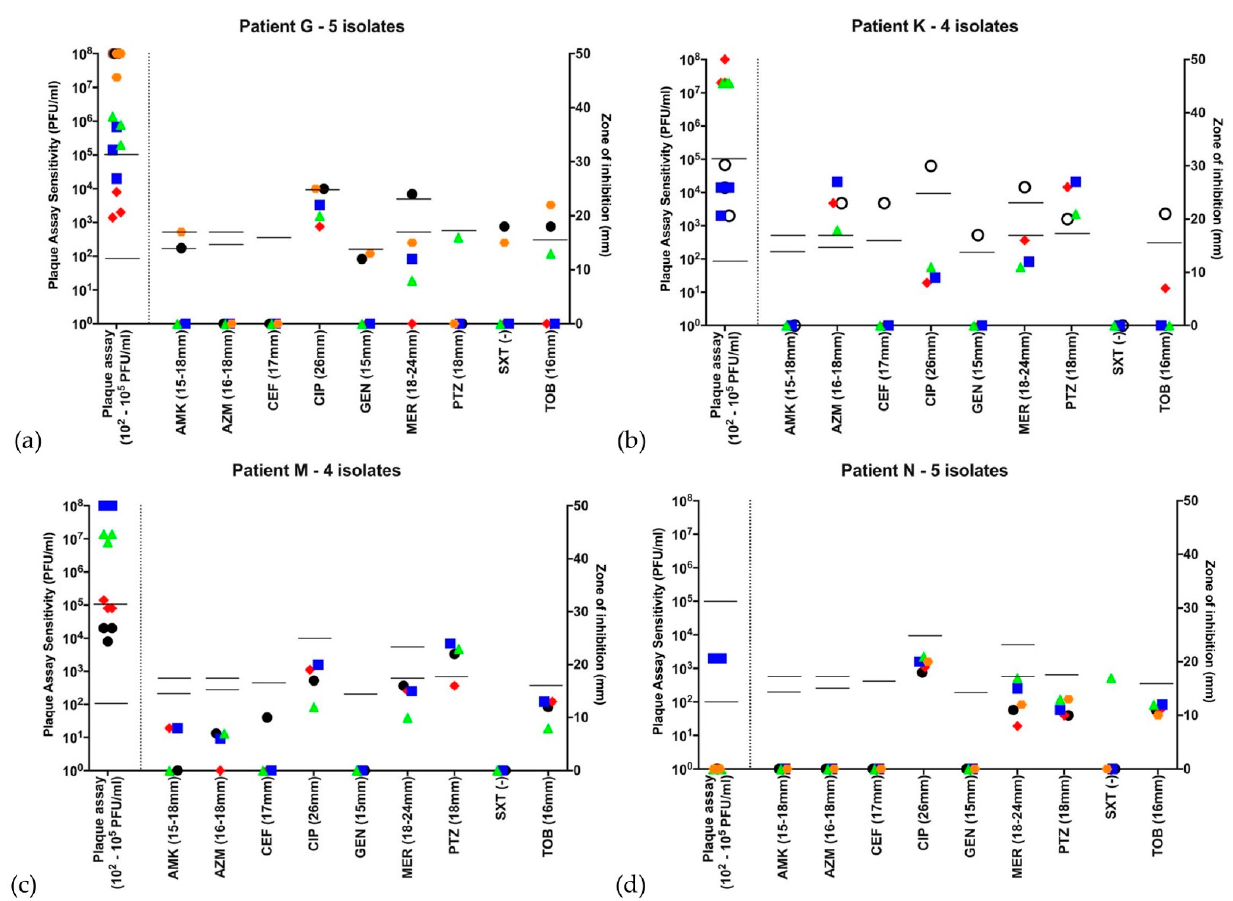
Figure 2. Antibiograms and bacteriophage sensitivity profiles for 4 patients with the Liverpool Epidemic Strain. Isolates are graphically represented by different symbols chronologically throughout the year. The first isolate is represented by , with subsequent isolates , , , , if there were 5 isolates through the course of 2016. Open symbols represent different strains, identified by VNTR analysis. Abbreviations – AMK: amikacin; AZM: aztreonam; CEF: ceftazidime; CIP: ciprofloxacin; GEN: gentamicin; MER: meropenem; PTZ: piperacillin-tazobactam; SXT: co-trimoxazole (no EUCAST breakpoint); TOB: tobramycin. Disc diffusion assay for antibiotic sensitivity testing was performed once at each time point and EUCAST sensitivity cutoffs are indicated by the bars. Biological triplicates of phage assay are represented individually and bars indicate both neat phage (>2 × 10 2 PFU/mL) and dilute phage (>2 × 10 5 PFU/mL) cutoffs. ( a – d ) Patients G, K, M and N were colonized with the LES. All strains qualified as MDR based on antibiograms and 14/18 (78%) LES isolates showed some lytic activity to phage using the lower sensitivity cutoff. Using the higher sensitivity cutoff of 10 3 serial dilutions, 9/18 (50%) showed sensitivity to phage. ( a ) Patient G had isolates that are broadly resistant to antibiotics-sensitive to tobramycin at 2 and to meropenem at 1 time points, respectively, but broadly sensitive to phage at all time points; ( b ) Patient K was colonized by a different strain at the first time point, but all subsequent isolates were LES with lytic activity to phage; ( c ) Patient M’s LES strain was sensitive only to piperacillin-tazobactam but sensitive to phage at all time points; and ( d ) Patient N was colonized with LES resistant to all antibiotics tested. Only 1 of this patient’s 5 isolates showed lytic activity to the neat phage cocktail and no isolates were deemed sensitive using the higher